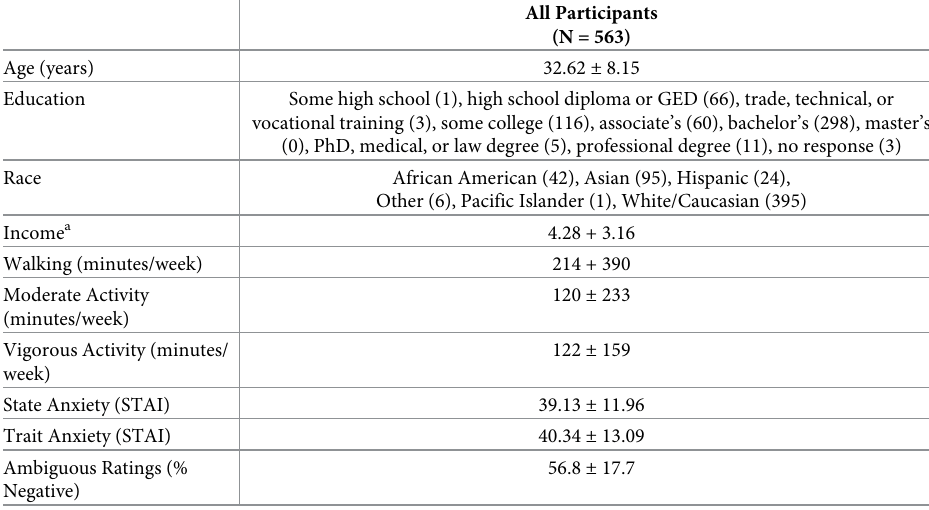
Table 1. Participant means and descriptive statistics M ±